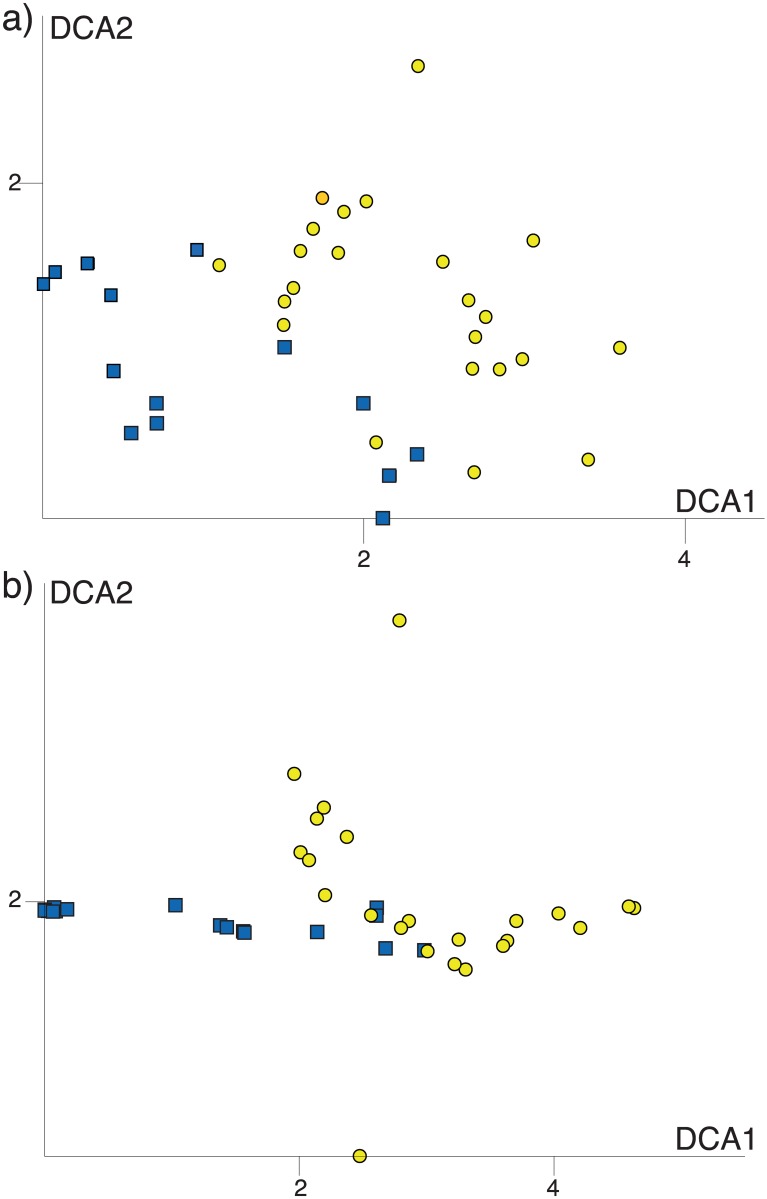
Detrended correspondence analysis (DCA) scores of diet content in samples found in Walia ibex (yellow circles) and domestic goat (blue squares).a) based on occurrence (presence/absence) and b) based on abundance of the 54 MOTUs. The DCA diagram is scaled in standard deviations units, which means that samples that are four units apart on average have a complete turnover in species (MOTU) composition. The same plant species are therefore unlikely to be found in samples that are more than four DCA units apart in the diagram.